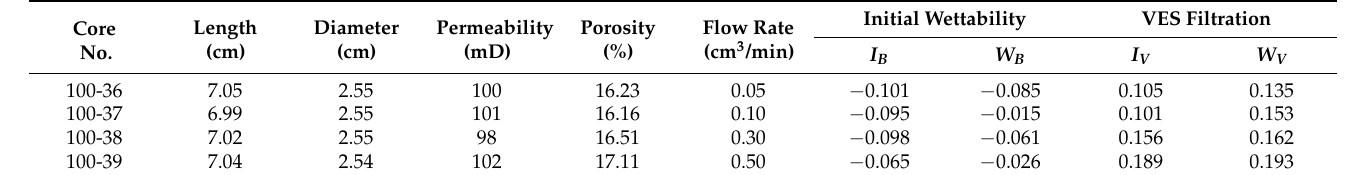
Table 5. Effect of flow rate on wettability.